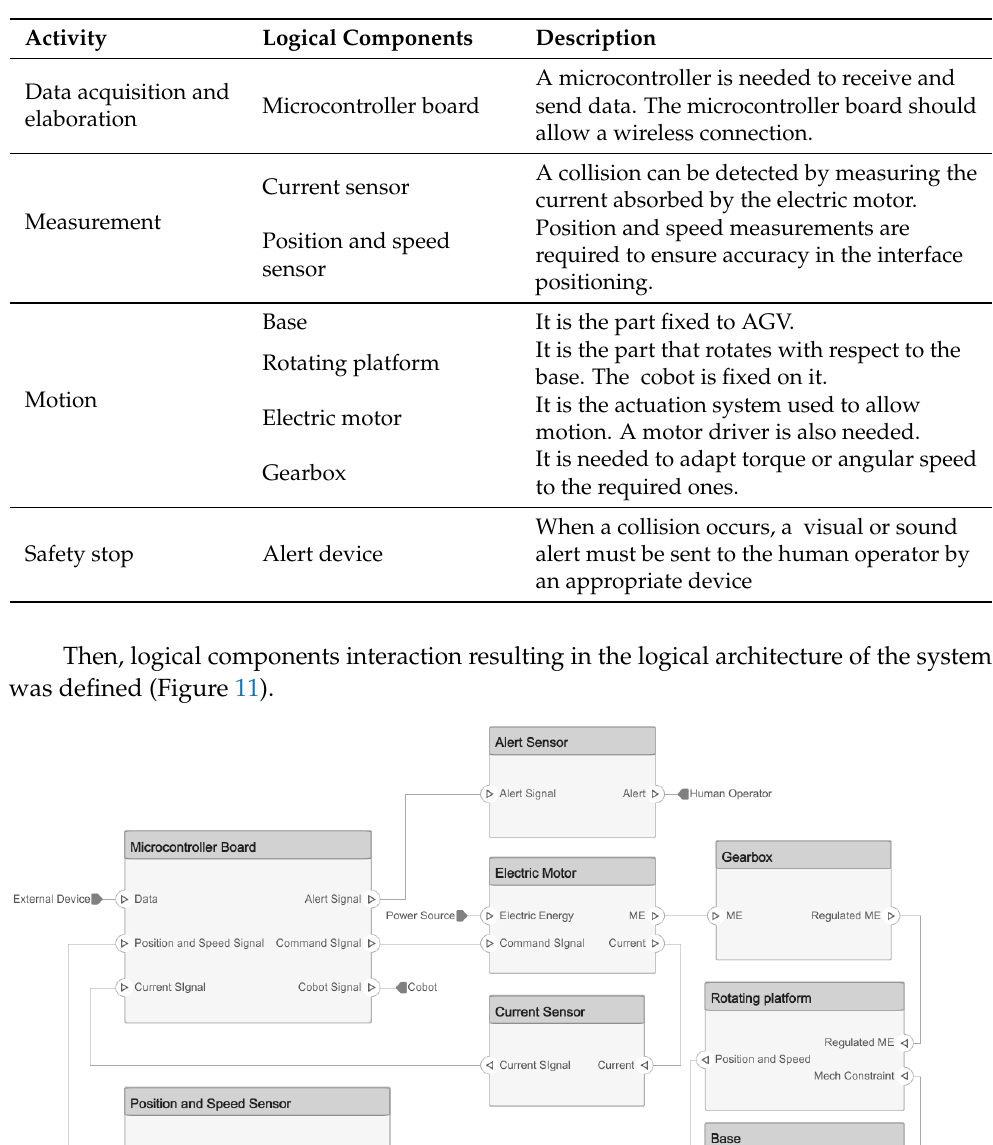
Table 2. Logical breakdown and allocation.